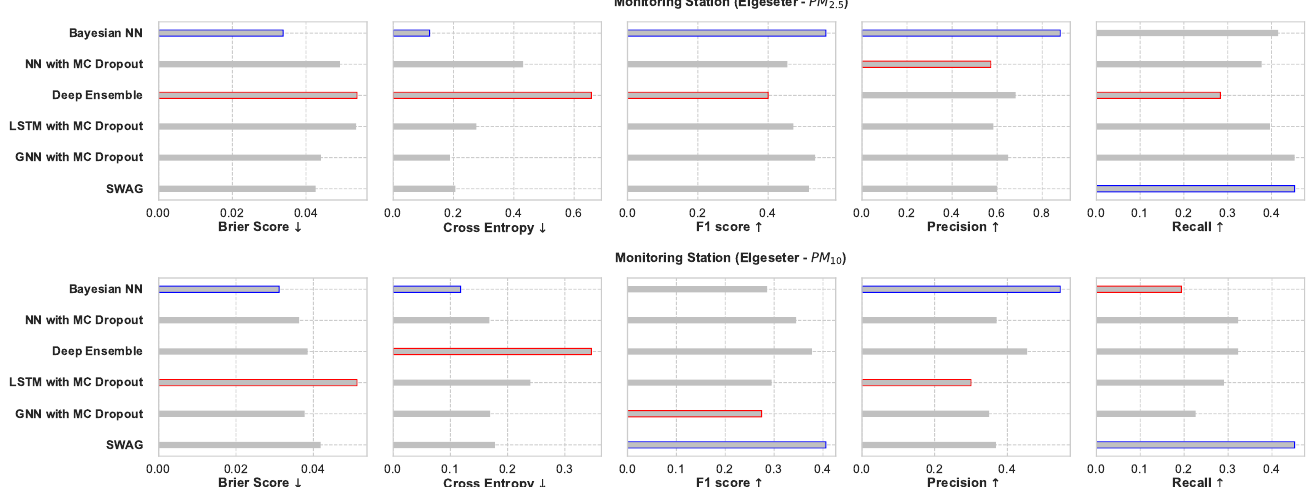
Figure 26. Comparison of empirical performance of the selected probabilistic models in the threshold exceedance classi- fication task. The comparison is according to five performance metrics (left to right): Brier score, cross-entropy, FI score, precision, and recall. Blue highlights the best performance, while red highlights the worst